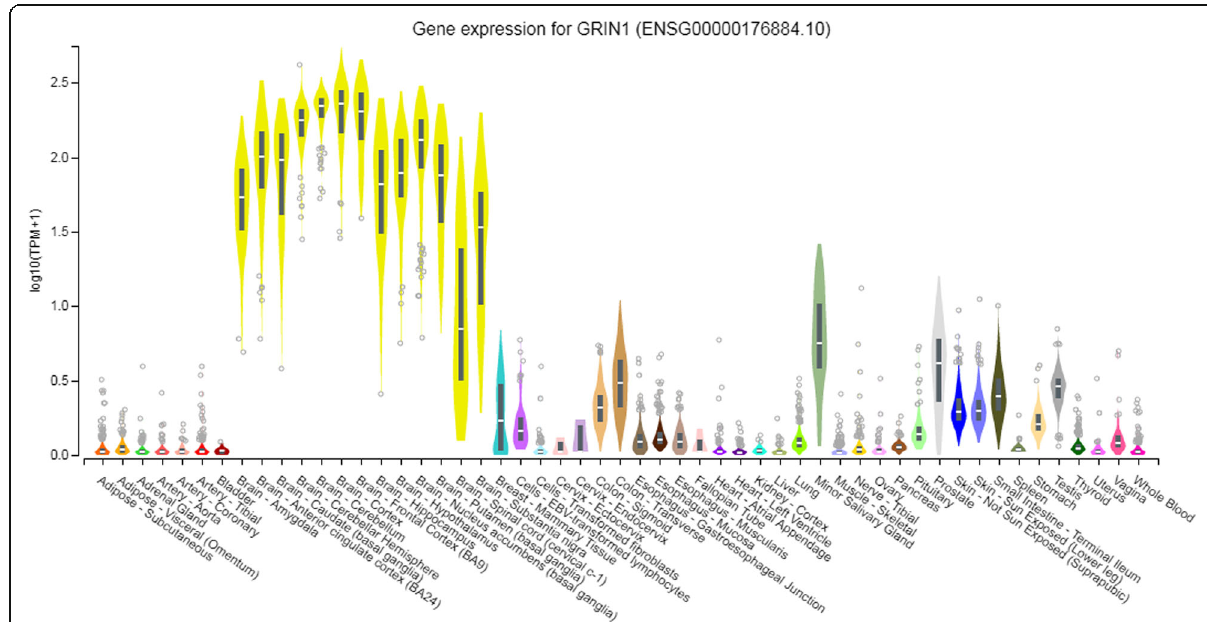
Fig. 3 GRIN1 gene expression in different tissues. TPM on the vertical axis represents the transcript quantification value, and the horizontal axis represents different tissues. The GRIN1 gene was highly expressed in brain tissue compared with other tissues